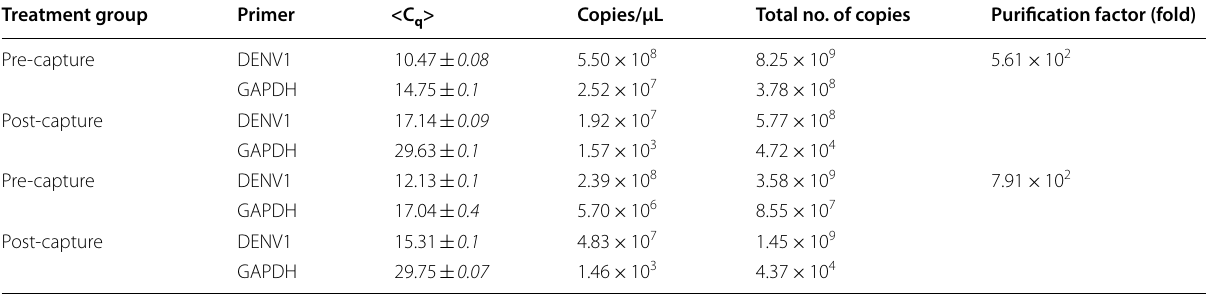
Table 1 Comparison of absolute quantities of DENV1 and GAPDH used for calculation of purification factor Treatment group